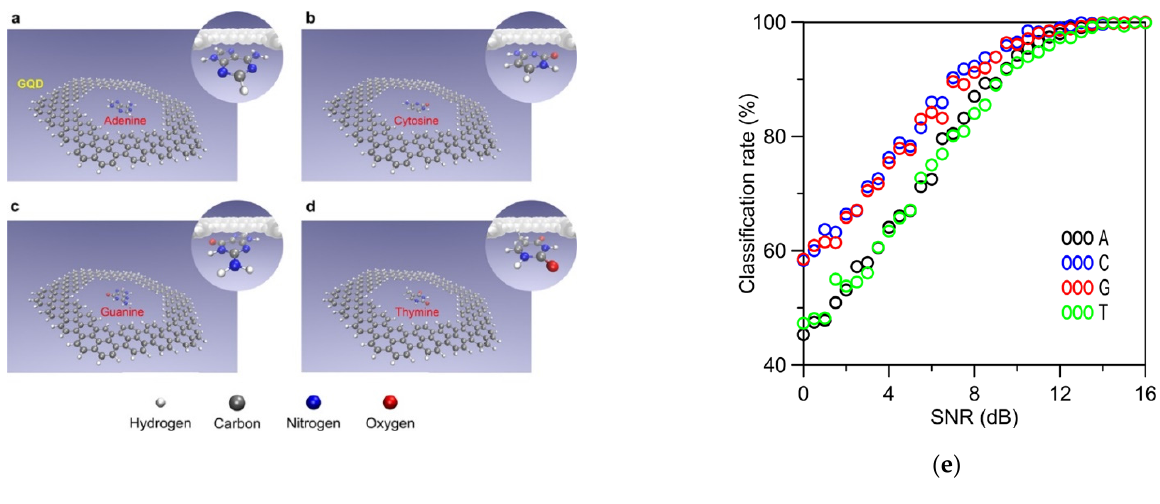
Figure 4. Graphene Quantum Dots (GQD) pores with nucleobases of ( a ) adenine, ( b ) cytosine, ( c ) guanine, and ( d ) thymine. For all the cases from ( a – d ), the length of the hexagonal GQD side was A = 1.8 nm and the side length of the pore was D = 1.0 nm. All the structures are relaxed and also binding atoms (hydrogen) to the pore and GQD edges are included. ( e ) Classification rates of unknown DNA nucleobases inserted into GQD (1.8,1.0) to nucleobases as a function of the signal-to-noise ratio (SNR). The classification rate is the percentage of the noisy samples, which are classified correctly to a type of DNA nucleobase. Adapted with permission from Abasifard et al. [35] Copyright © 2019 American Chemical